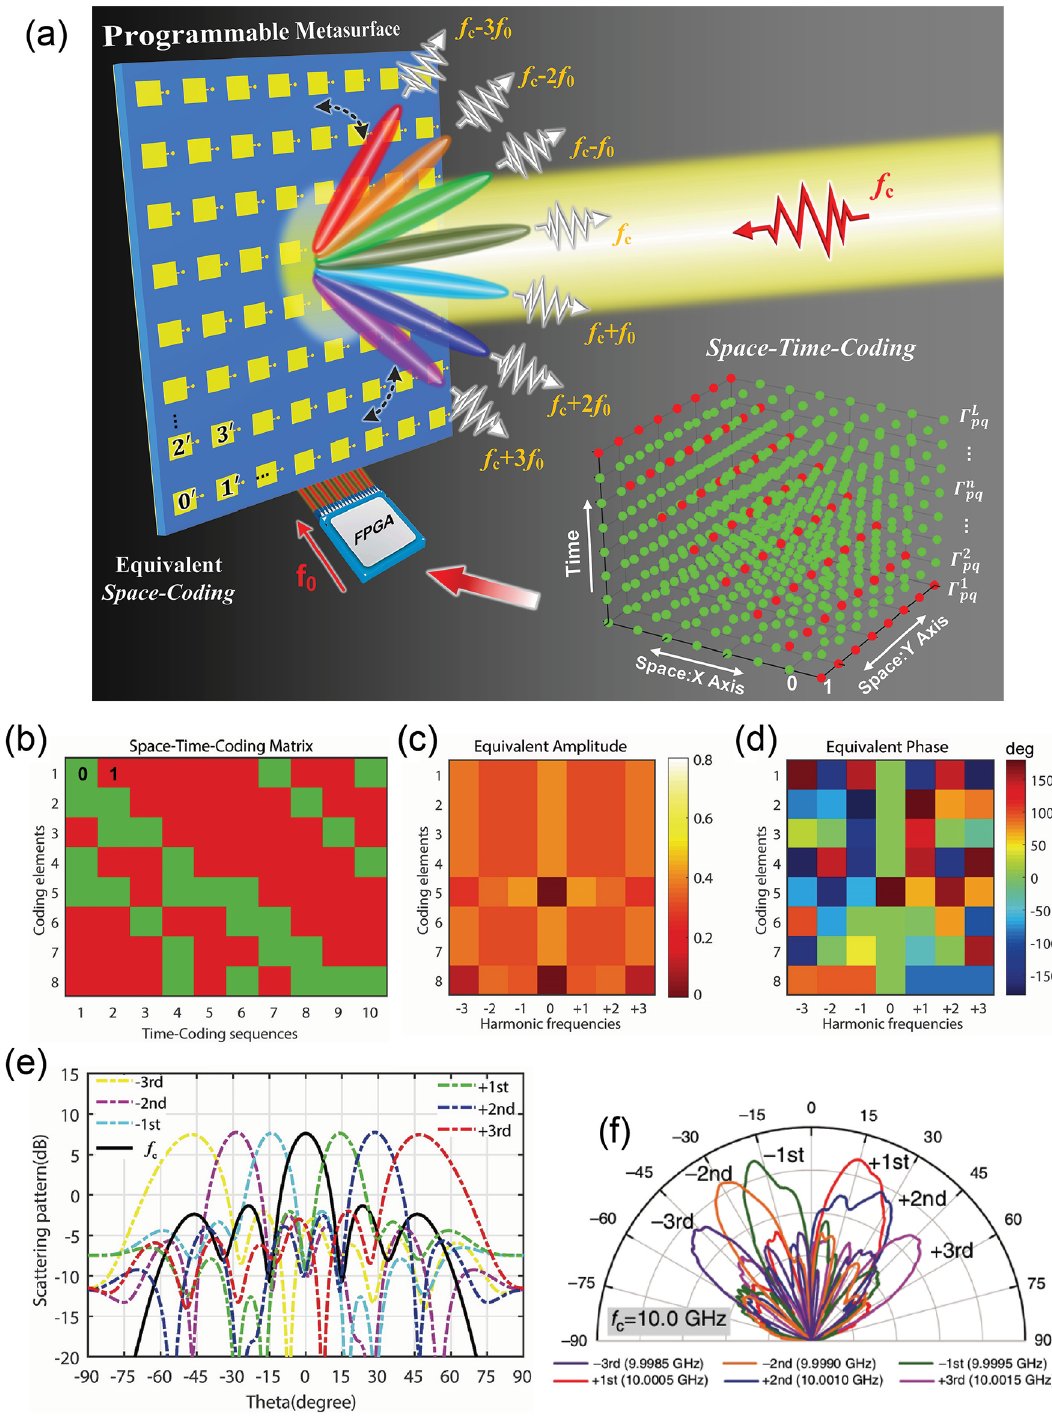
Fig. 1. Harmonic beam steering (adapted from [25]). (a) Conceptual illustration. (b) Optimized space-time-coding matrix. (c, d) Equivalent amplitudes and phase distributions, respectively, at the various harmonic frequencies. (e, f) Simulated and measured, respectively, scattering patterns at various harmonic